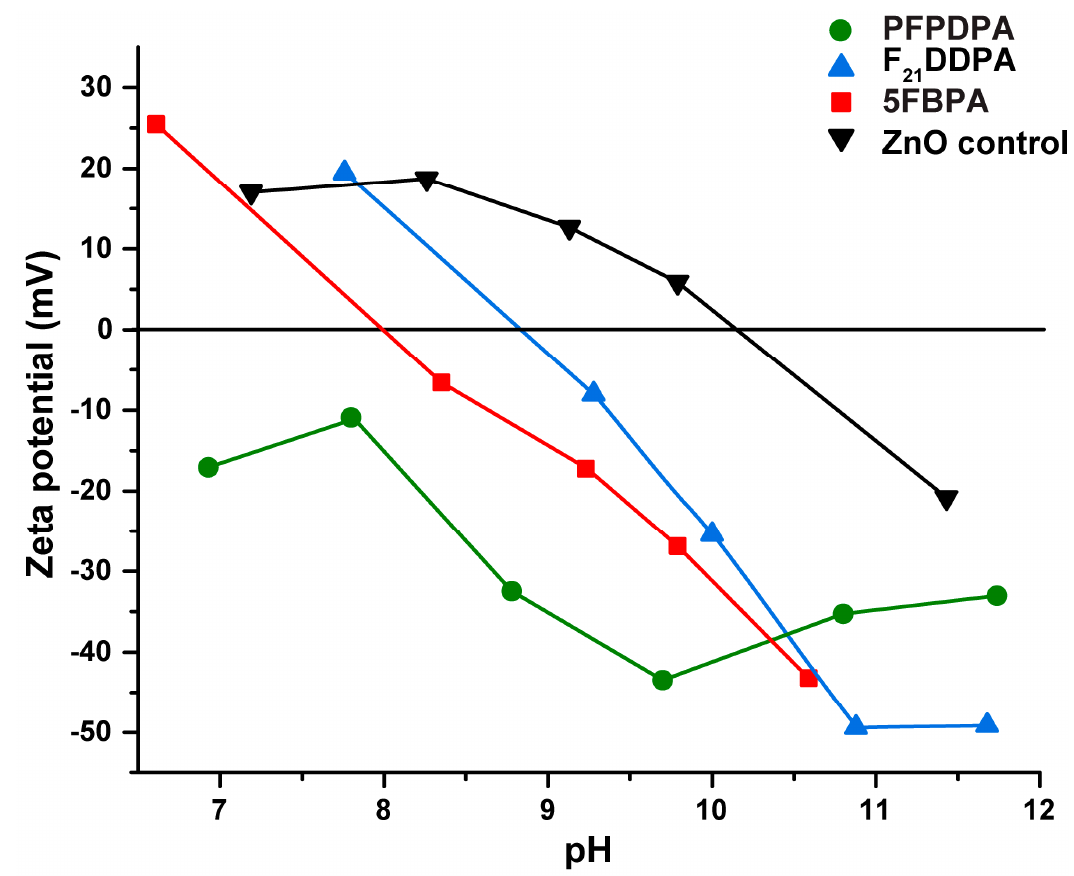
Figure 6. pH dependence of the zeta potentials of surface functionalized ZnO films and unmodified ZnO nanoparticles.